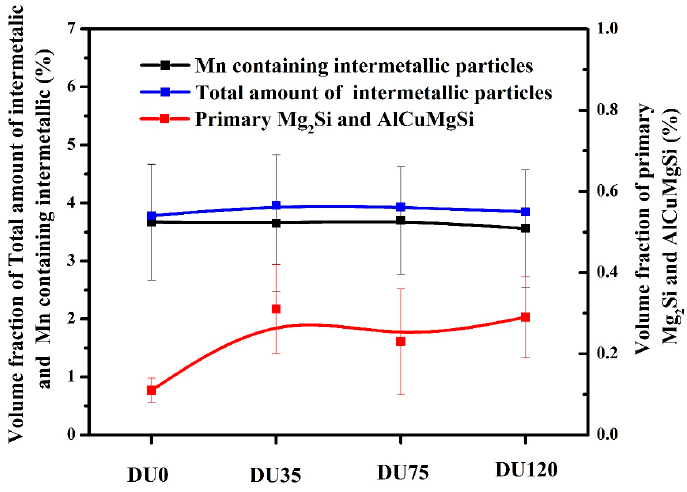
Figure 3. The volume fractions of intermetallic particles in four experimental alloys.